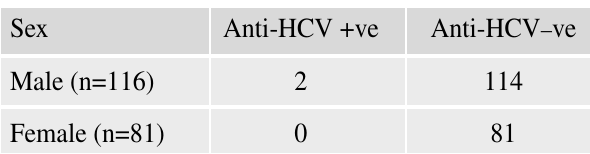
Table 1: Seroprevalence of anti-HCV among